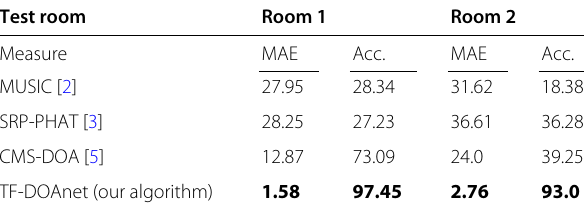
Table 4 Results for two different test rooms with simulated RIRs Test room